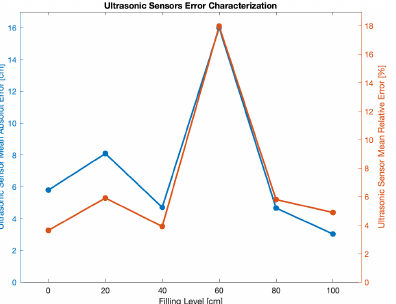
Figure 8. Absolute and relative errors of the measured values.